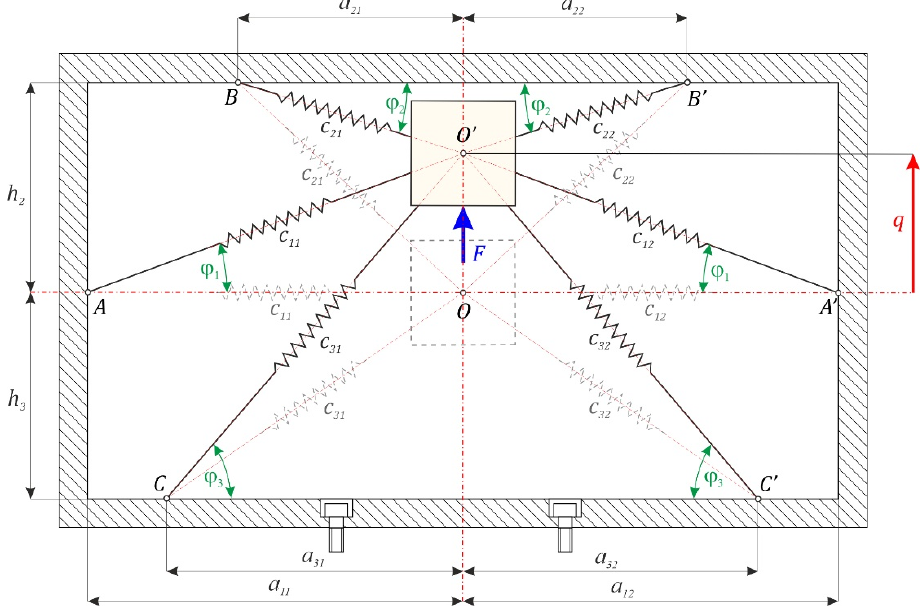
Figure 2. Schematic diagram which was used for identifying effective mechanical characteristics. The system parameters provided in the figure are discussed in the text.